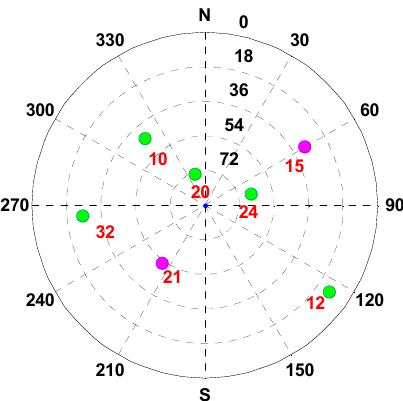
Figure 3. The sky plot of satellites for the epoch 1950 s, in which the green and magenta dots denote the blocked and visible satellites, respectively.